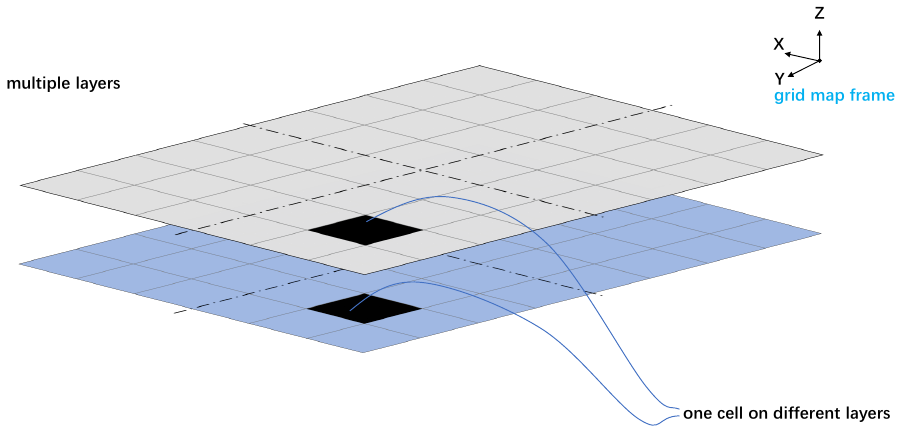
Figure 4. Our approach uses multilayered grid maps to store data for different types of information. Concretely, every grid saves a 1 × 3 matrix including location information and resistance or grade, depending on which layer it is. A grid with site information will be created after the vehicle passes by. The map is saved as a 2 × m × n × 3 tensor, where m is the max displacement in the x-direction, while n is the max displacement in the y-direction. In case a grid is not occupied once by the vehicle, it will be marked as NaN to denote the unknown regions.